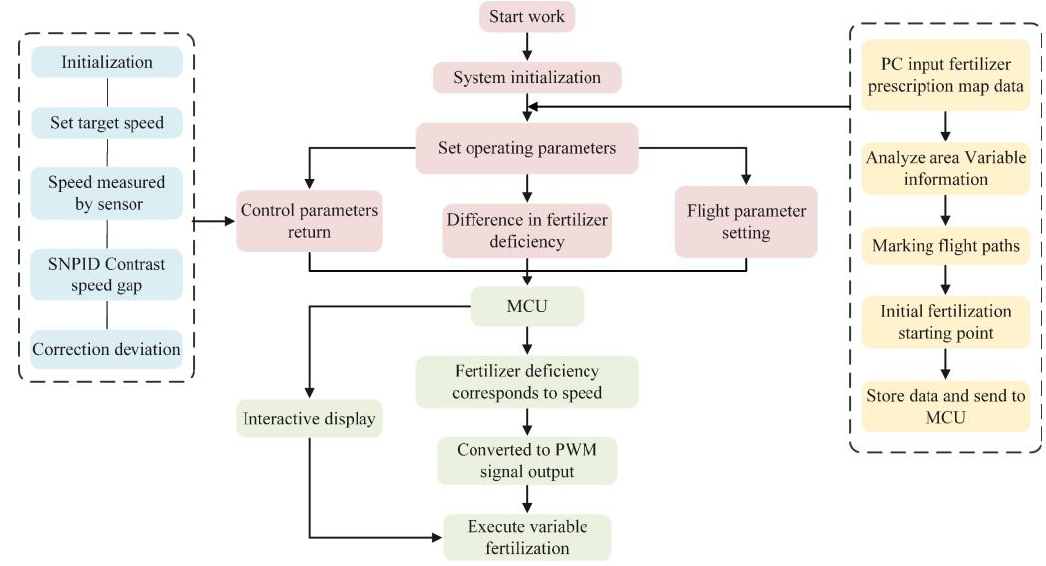
Figure 4. Control process of variable fertilizer application system.